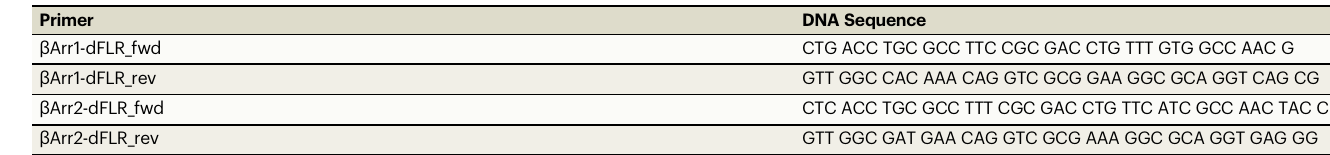
Table 2 | Primers used to design β -arrestin-dFLR constructs Primer DNA Sequence β